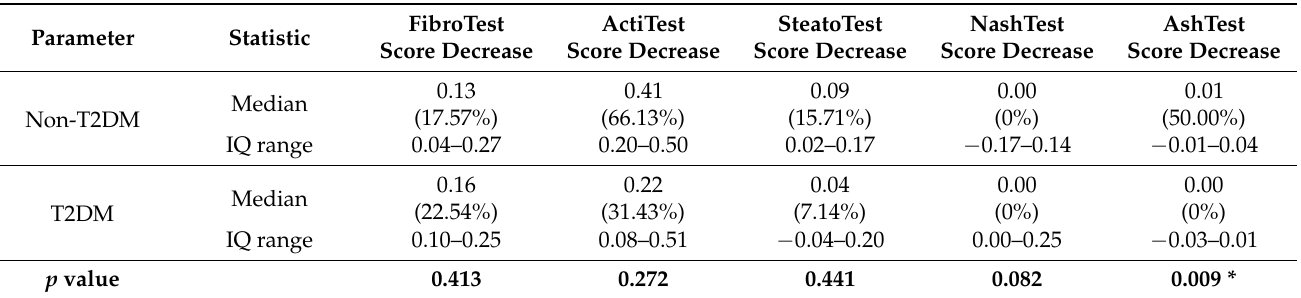
Table 3. Variation in FibroMax parameters after DAA treatment in non-T2DM patients vs. in T2DM patients.